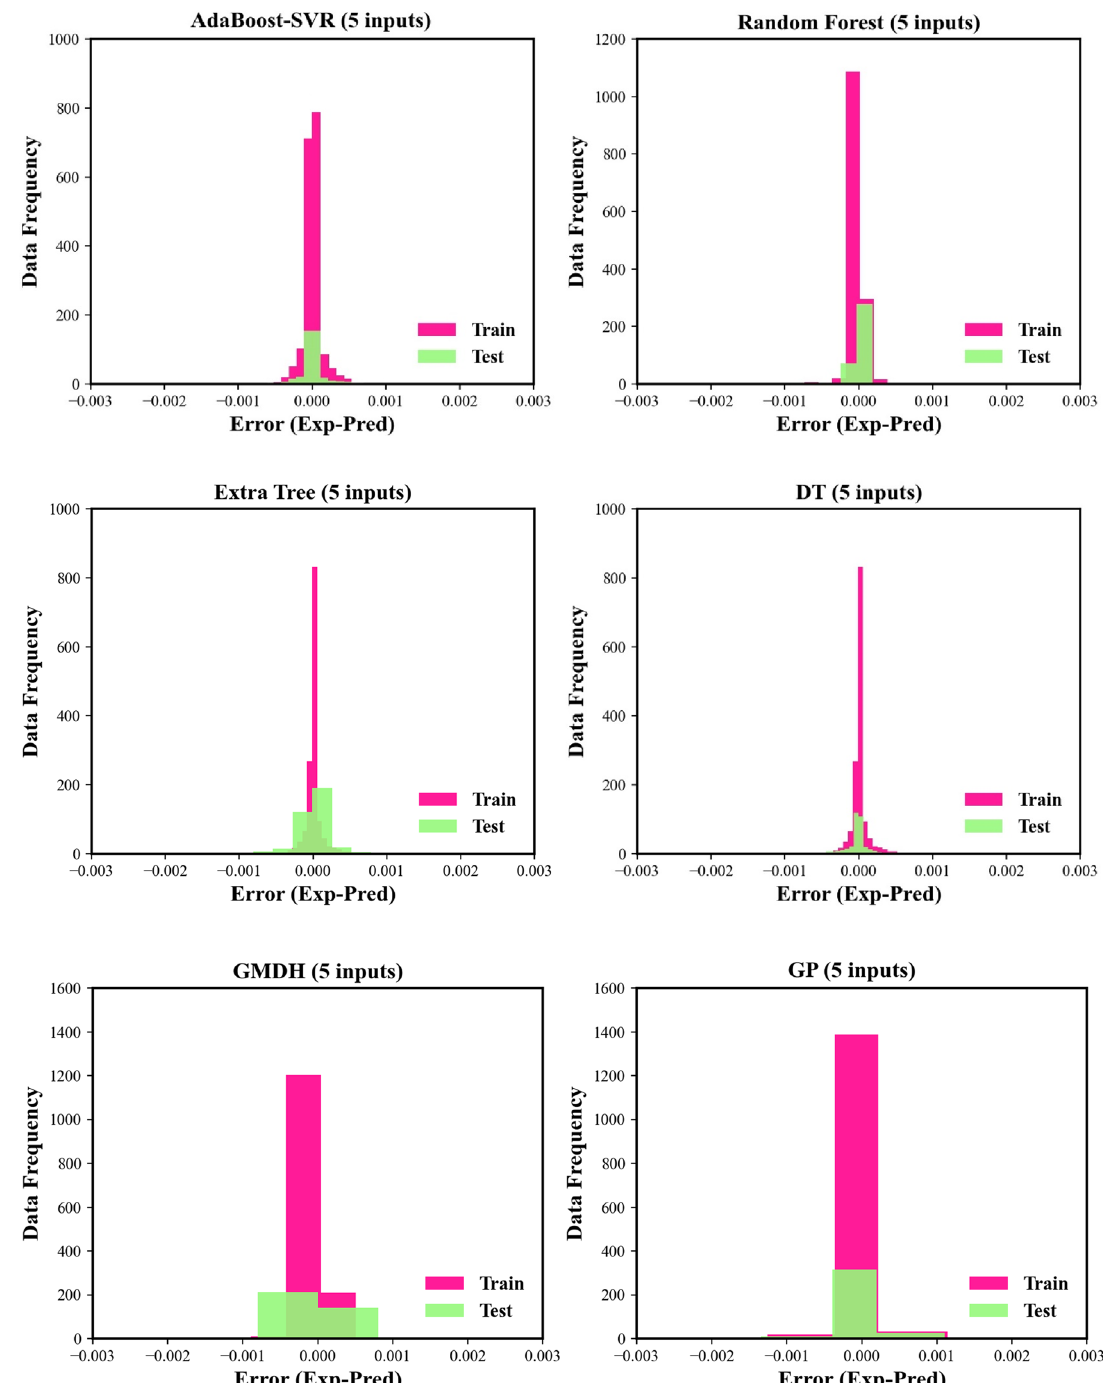
Figure 5. Histograms of residuals for the machine learning models and